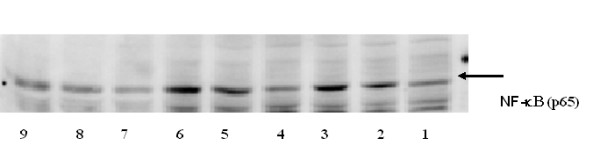
Phosphorylated p65 subunit of NF-kB was determined by western blot with a monoclonal antibody. 1) HepG2, 2) TNF-α at 20 ng/m; 3) TNFα at 100 ng/ml; 4) BSA 5) BSA+TNF-α at 20 ng/ml; 6) BSA+TNF-α at 100 ng/ml; 7) palmitate; 8) palmitate + TNF-α at 20 ng/ml; 9) palmitate + TNF-α at 100 ng/ml.